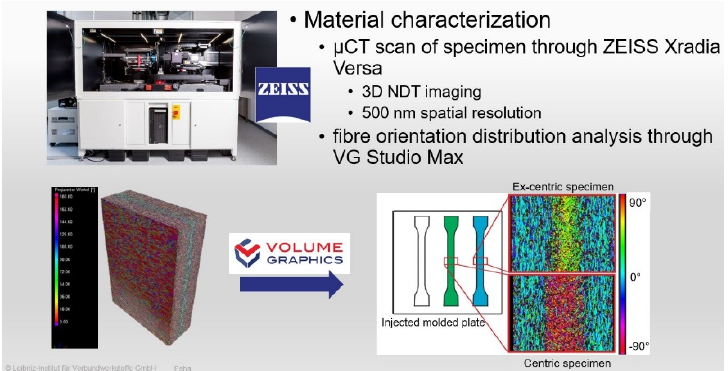
Figure 2. Material characterization to find out the optimized position of the specimens in the injec- tion-molded plate. molded